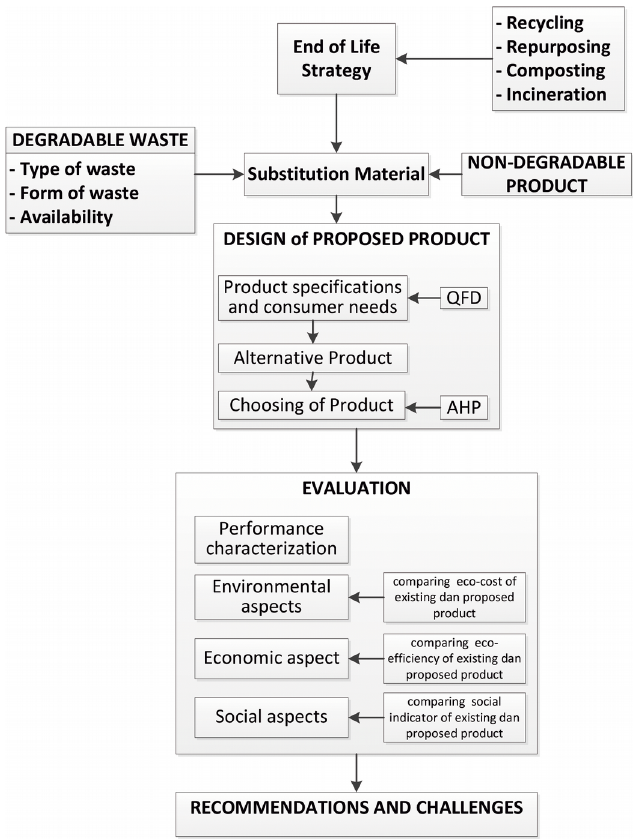
Figure 1. The framework for material